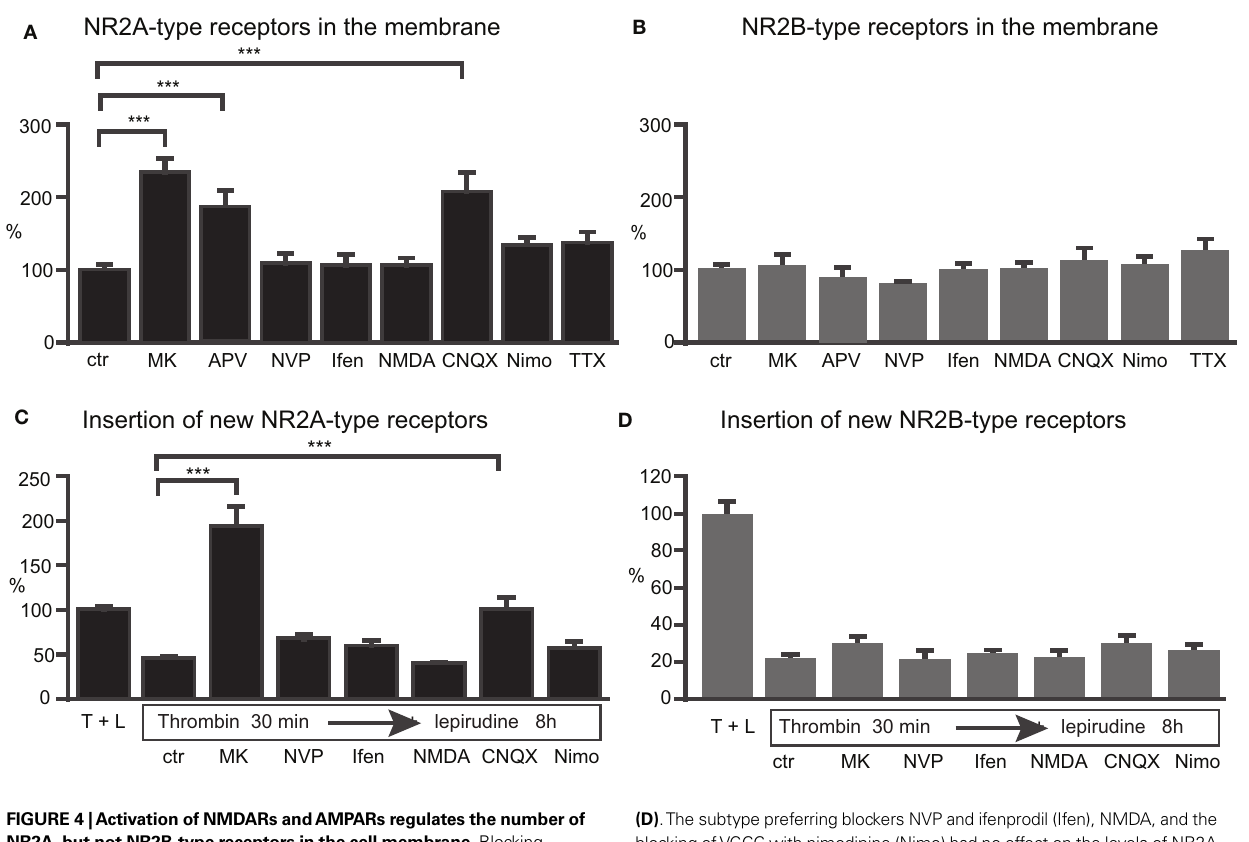
FIGURE 4 | Activation of NMDARs and AMPARs regulates the number of NR2A- but not NR2B-type receptors in the cell membrane. Blocking NMDARs with MK-801 (MK), APV and CNQX for 8 h increased the surface staining for the tagged NR2A- (A) but not NR2B-subtype (B) . (C,D) The increase in membrane-bound NR2A-type receptors can be explained by increased insertion of new receptors during the treatment with MK-801 and